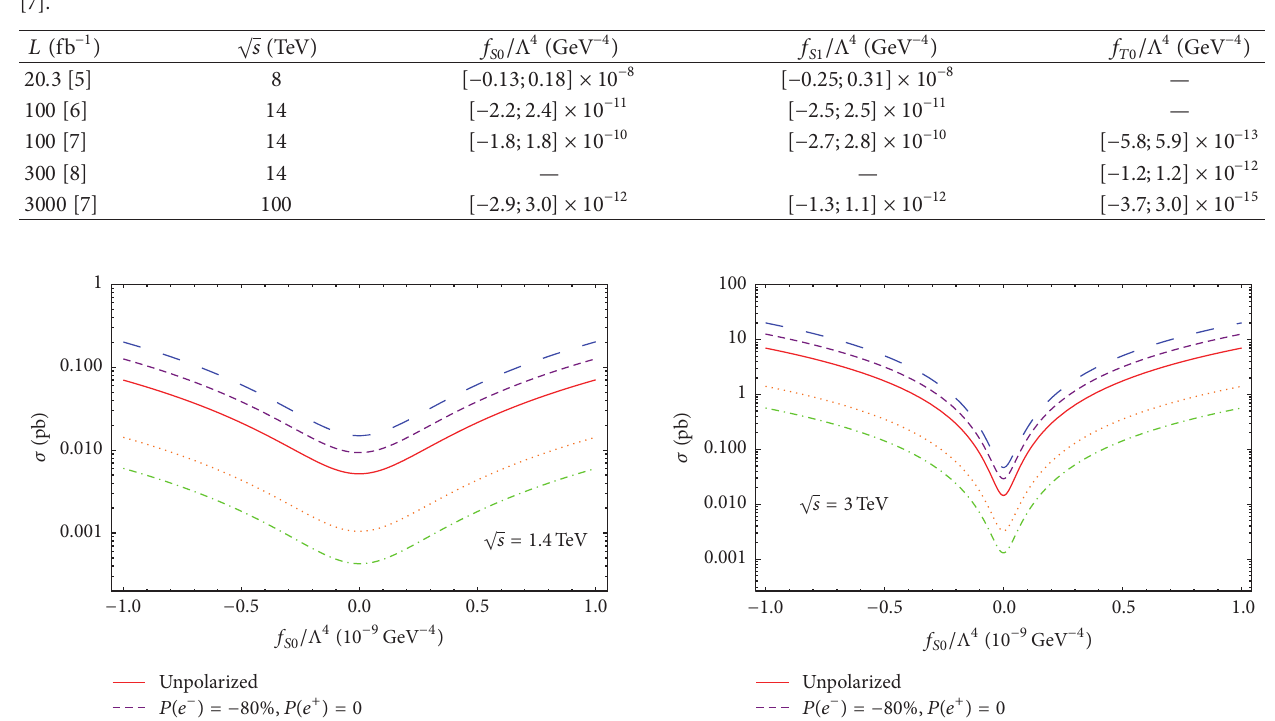
Table 2: Current sensitivity bounds on anomalous parameters for 95% CL with 20.3 fb −1 for √𝑠 = 8 TeV [5], 99% CL with 100 fb −1 for √𝑠 = 14